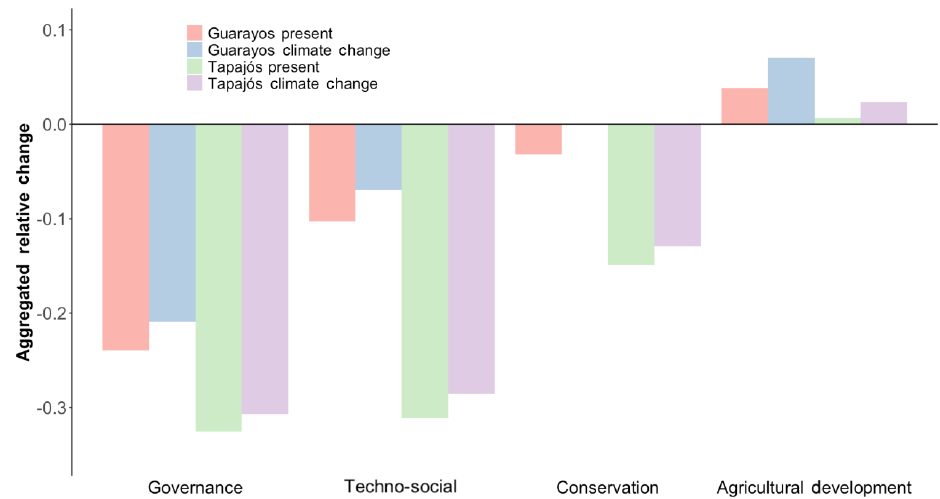
Figure 9. Aggregated relative change and response of scenarios under present climatic conditions and climate change. Negative values represent a desirable change in the system. Positive values represent an undesirable change in the